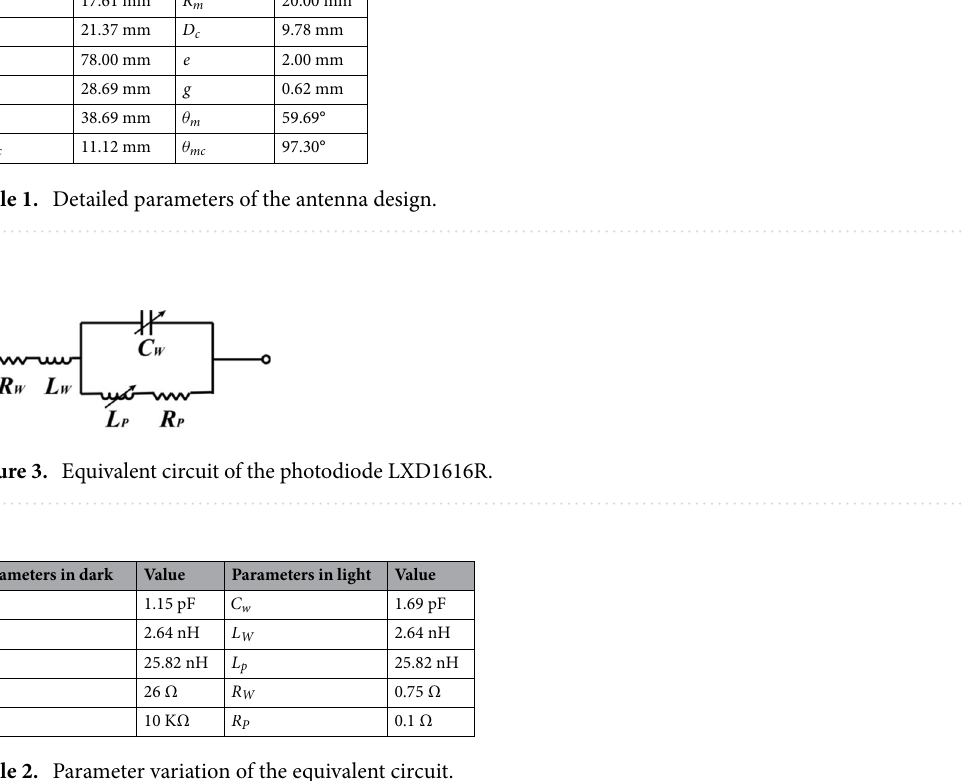
Table 2. Parameter variation of the equivalent